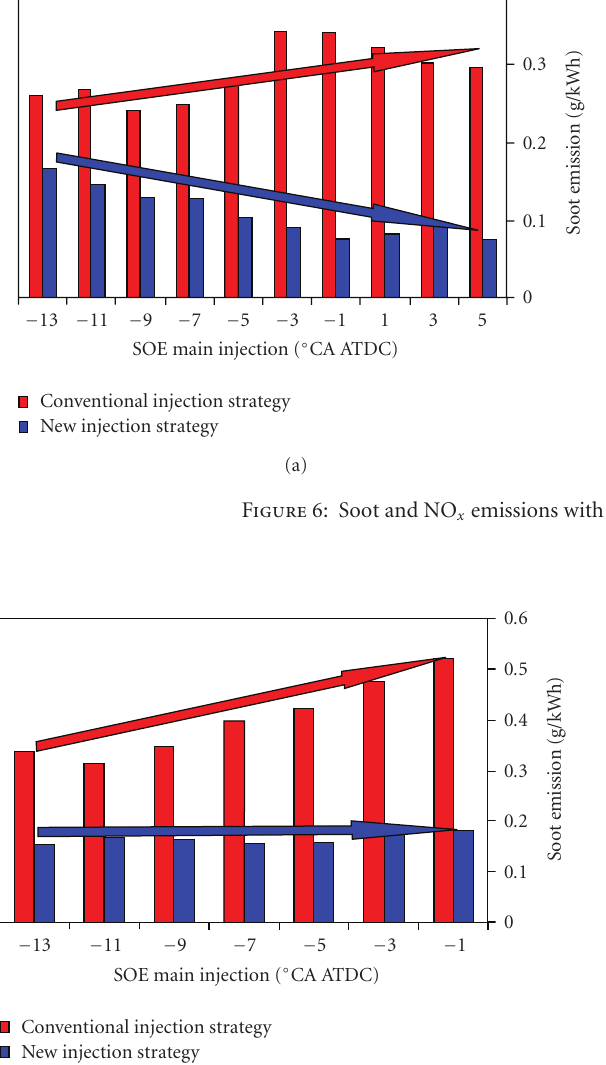
Figure 7: Soot emissions with injection timing variation and 35%